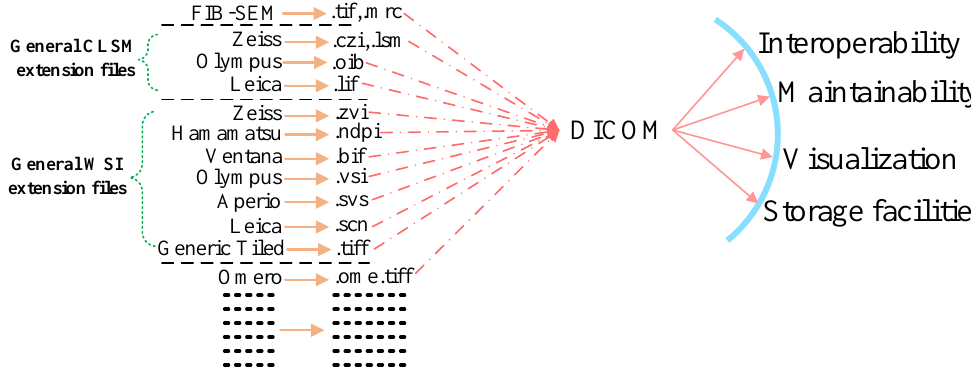
Figure 1. Depiction of the conversion of distinct proprietary files into DICOM, with advantages,